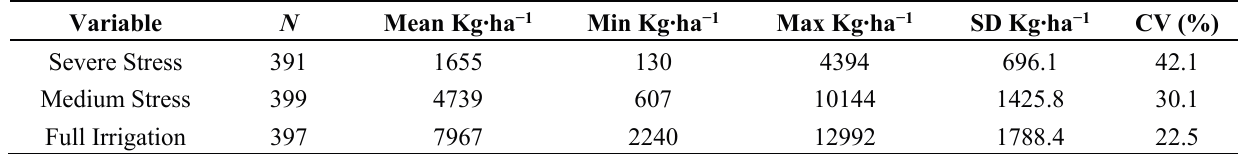
Table 1. Main statistical parameters of grain yield for the 368 genotypes growing under three water regimes.